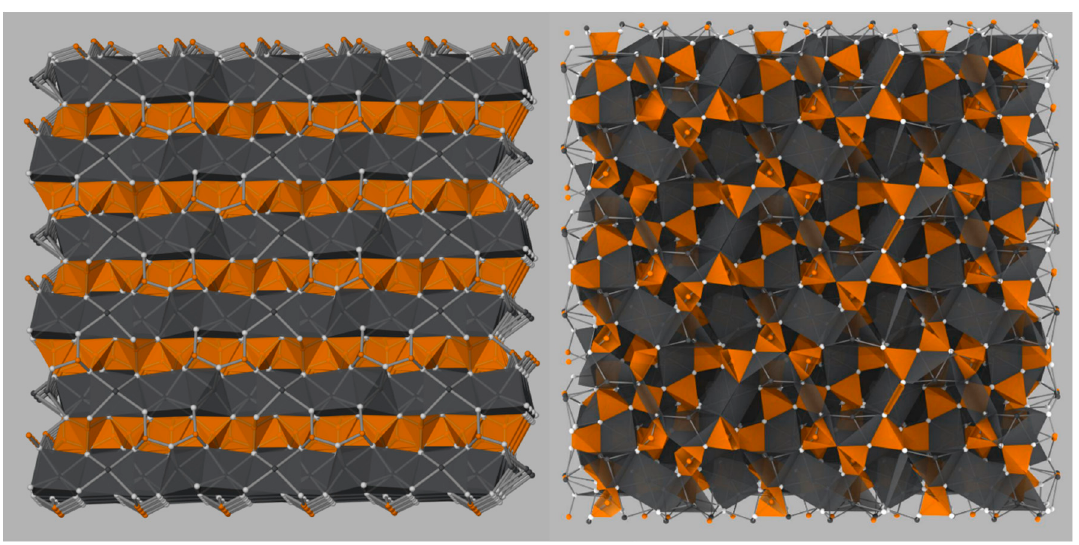
Figure 2 . Comparison of the ordered layered C5A3 structure ( left ) and the C12A7 cage structure ( right ). Ca cations and coordination polyhedra are shown in gray, Al cations and coordination polyhedra are shown in orange, and oxygen anions are shown in white. Reproduced from Salasin and Rawn [5].